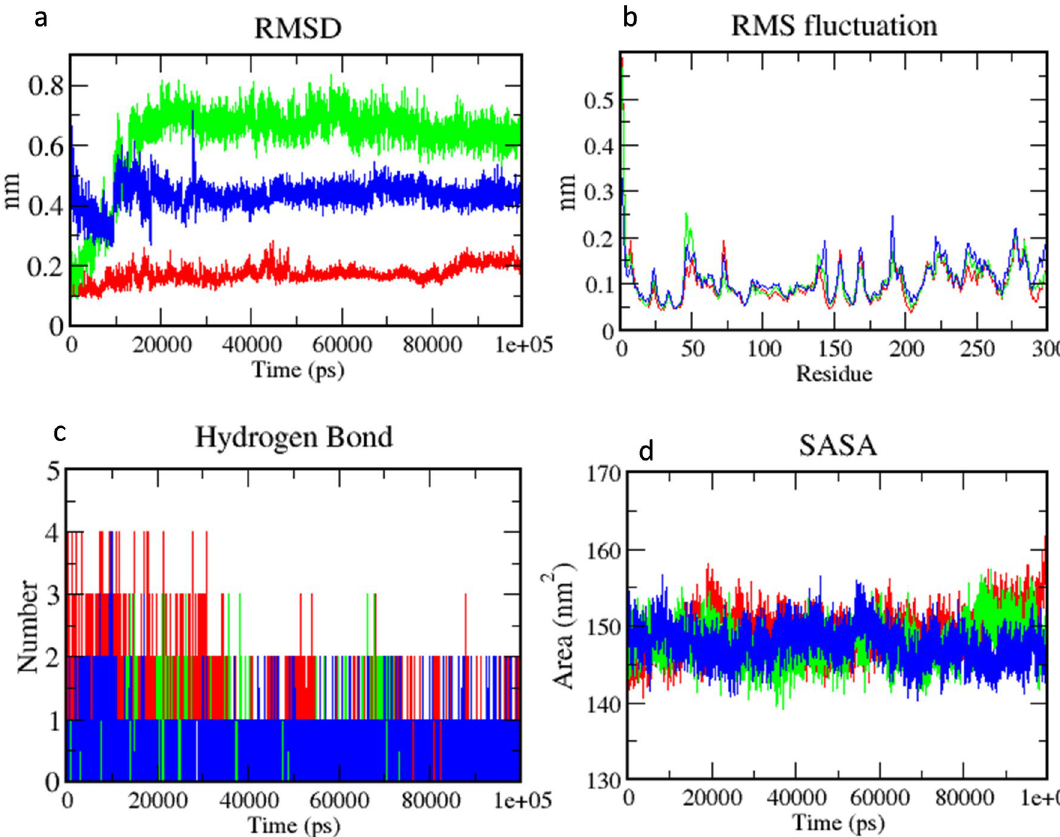
Figure 8. Binding stability analysis of the screened lignads during 100 ns molecular dynamics simulation (hit 9-green, hit 10—blue, reference—red): ( a ) Root Mean Square Deviation (RMSD), ( b ) Root Mean Square (RMS) Fluctuation, ( c ) hydrogen bond analysis, and ( d ) Solvent Accessible Surface Area